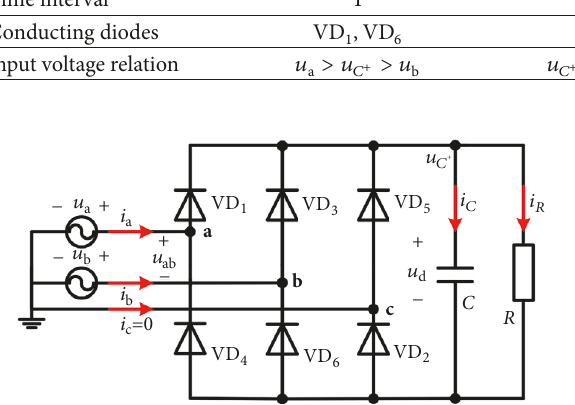
Figure 6: Three-phase bridge rectifier circuit running under single- phase short-circuit condition.